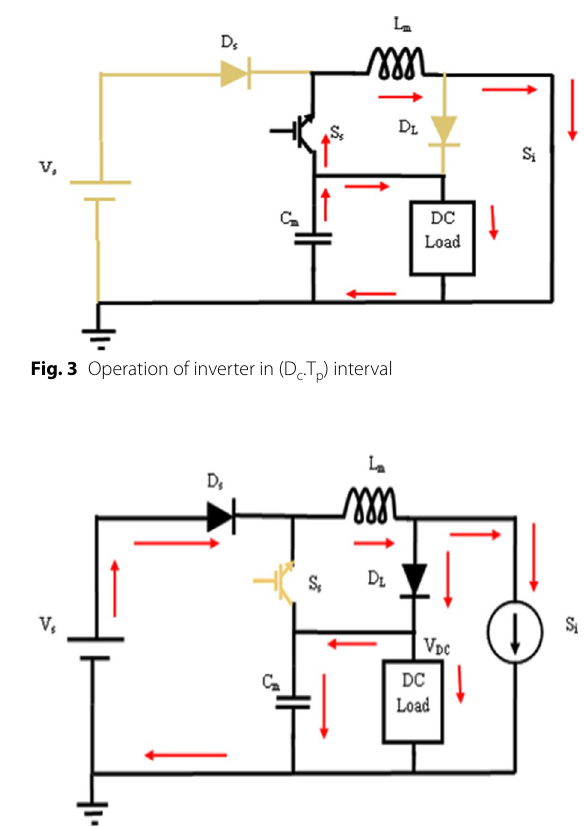
Fig. 6 Inductor current I Lm during interval (1